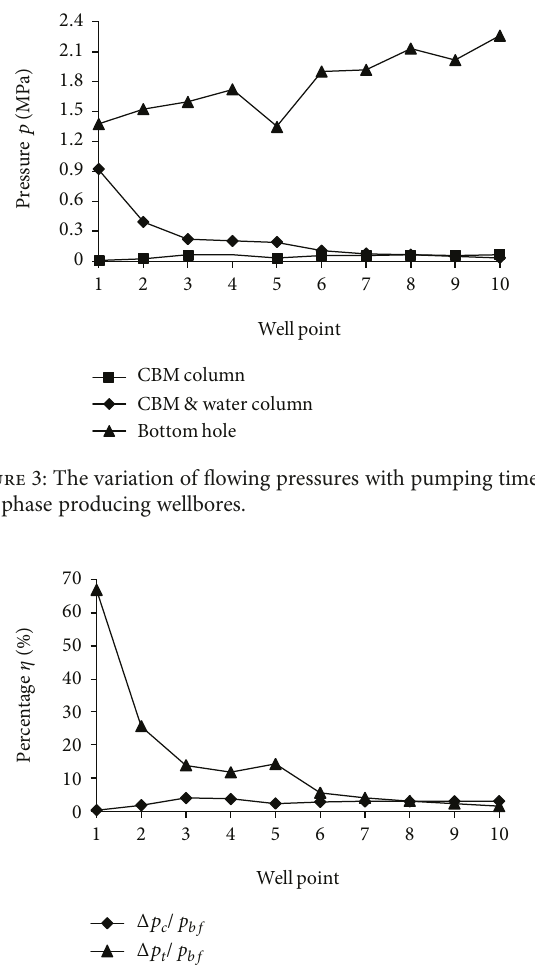
Figure 4: The ratios of fl owing pressures in two-phase producing wellbores.